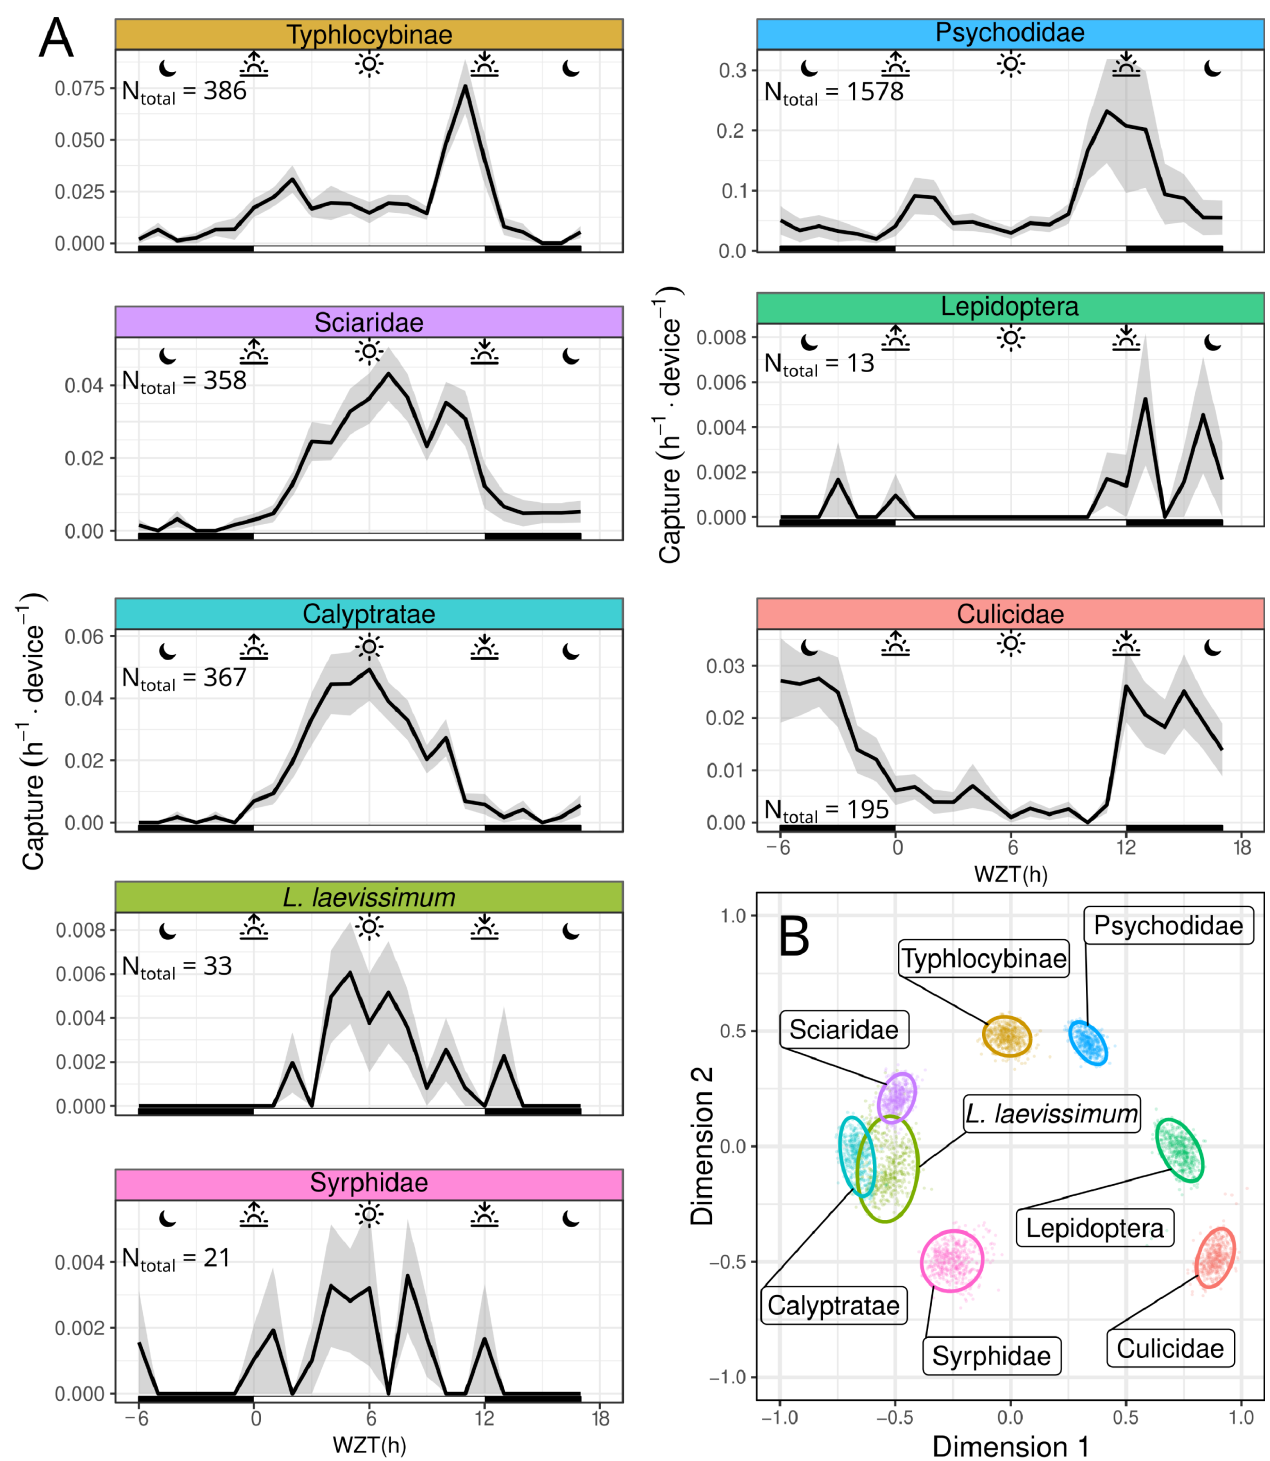
Fig 6. Sticky Pi reveals community chronoecology. In order to assess the activity pattern of a diverse community, we deployed 10 Sticky Pis in a raspberry field for 4 weeks, replacing sticky cards weekly. This figure shows a subset of abundant insect taxa that were detected by our algorithm with high precision (see Supporting information for the full dataset). (A) Average capture rate over time of the day (note that time was transformed to compensate for changes in day length and onset—i.e., Warped ZT: 0 h and 12 h represent the sunset and sunrise, respectively. See Methods section). (B) MDS of the populations shown in A. Similarity is based on the Pearson correlation between the average hourly activity of any 2 populations. Small points are individual bootstrap replicates, and